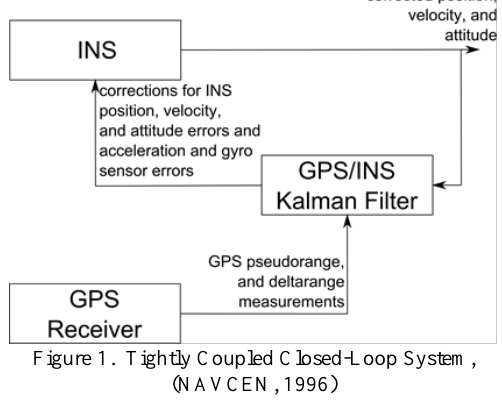
Figure 1. Tightly Coupled Closed-Loop System, (NAVCEN, 1996)